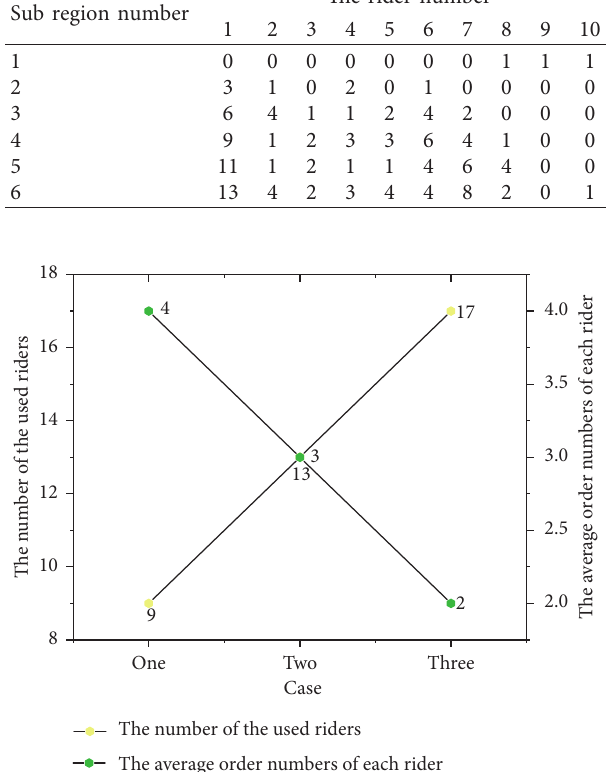
Table 6: Number of riders in 23 sub-regions for instant deliveries. No.